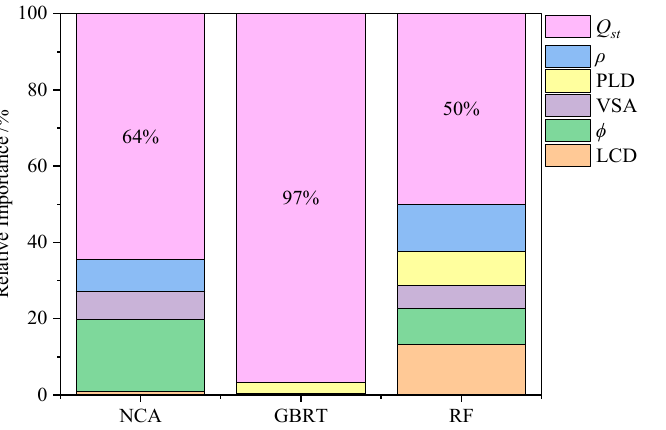
Figure 4. Relative importance of the six descriptors on the selectivity of MOFs by three ML prediction. Furthermore, the predictive ML model should be used to accelerate the new HTCS for the other MOF database. Of course, both the simple binomial/trinomial fitting and ML model could achieve this H 2 O-MOF system, because of the strong relativity of Q st , but ML model would possess higher universality for the other gas-MOF system. Thus, we have added the prediction of a new MOF database (137,953 hMOFs) [28] by ML model, which was trained by 6013 CoRE-MOF datasets. First, Q st was calculated for all 137,953 hMOFs, and then we selected 10,000 hMOFs with the highest Q st for the new prediction, because Q st has the highest importance. As shown in Figure 5a–c, after the predicted results were compared with simulated results by molecular simulation, R 2 of the prediction in NCA could reach 0.86. The reasons for the differences of performance between training and predicting are that there exist some differences between the CoRE-MOF and hMOF databases. For examples, there are more than 350 topologies in the CoRE-MOFs database, while there are only six topologies in the hMOFs database, which leads to a diversity gap in those databases; CoRE-MOFs contain much more open metal sites or non-skeleton ions than hMOFs [28]. In this work, the establishment and evaluation of models are finished by 6013 CoRE-MOFs. Ten thousand hMOFs are the extra data, which are different from CoRE-MOFs in some aspects and do not participate in the establishment and evaluation of models. The difference between NCA and GBRT/RF could be that GBRT overemphasizes the importance of Q st (relative importance ≈ 97% in Figure 4); that is, the GBRT model is almost only built by a variable ( Q st ) and RF may fail to grasp the importance of features other than Q st . Therefore, GBRT and RF may be suitable for the prediction of CoRE-MOFs but not hMOFs, which also means NCA is more universal. Nevertheless, the prediction of NCA for 10,000 hMOFs still shows the sufficient predictive ability of the model, but it is usually not as effective as the original dataset [59]. Moreover, it can be found that, when a hMOF possesses high selectivity (log 10 S > 5.3), the model performs very well. Thus, the ML model obtained by the CoRE-MOF database can pre-screen out low-performance MOFs to greatly reduce the running time of molecular simulation. Based on the ML algorithm, 80 hMOFs with high performance (log 10 S > 5.3) could be precisely screened out, and then only the selected 80 hMOFs would have to have their simulated adsorption behavior calculated, as opposed to 137,953 hMOFs, saving a considerable amount of time and computing resource. Finally, the optimal hMOFs were listed in Table S6.